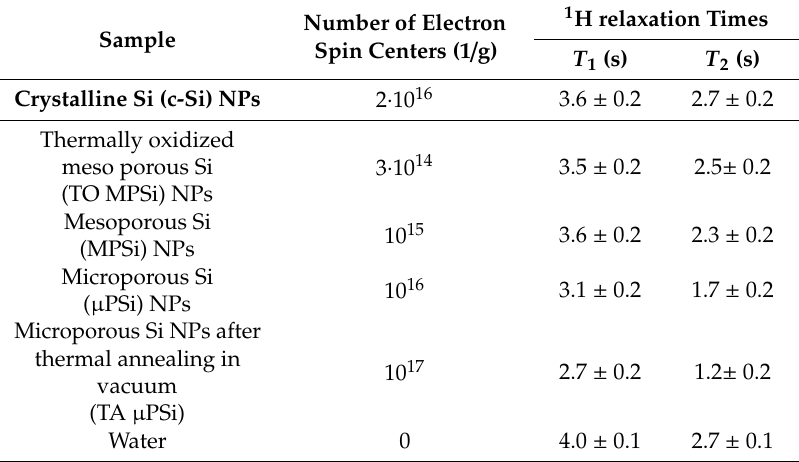
Table 1. Electron spin concentration for several types of Si NPs and proton relaxation times T 1 and T 2 in aqueous suspensions with NP concentration of 1 g / L and for pure water, for comparison. (Reprinted from Reference [96] by permission from John Wiley and Sons ©